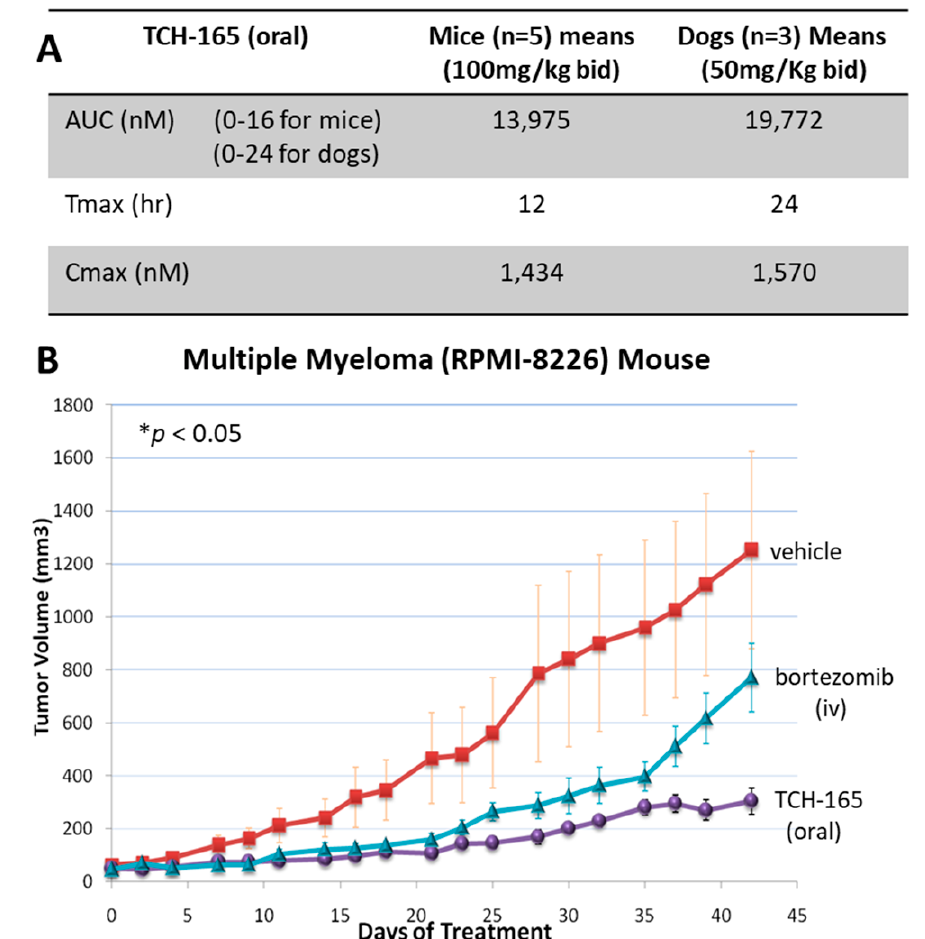
Figure 5. In vivo efficacy and tolerance of the proteasome activator, TCH-165. ( A ) Comparative analysis AUC, Tmax and Cmax of TCH-165 bid in mice (n = 5) and dogs (n = 3), calculated using PKSolver [45]. ( B ) RPMI-8226 subcutaneous xenograft model in SCID mice treated with vehicle (3:7 ( v/v ) propylene glycol/5% dextrose), and TCH-165 (100 mg/kg, bid with oral gavage), bortezomib (at 0.375 mg/kg day 0, 0.18 mg/kg day 2, 0.09 mg/kg day 5 and beyond) was given 3X per week intravenously. Tumor volumes show a significant difference between TCH-165 vs. control as well as TCH-165 vs. bortezomib groups at FDR of 0.0014 and 0.0127, respectively, using the pairwise Wallis test showing significant p -value of 0.0286 across all treatments, calculated using R Stats v3.6.2.